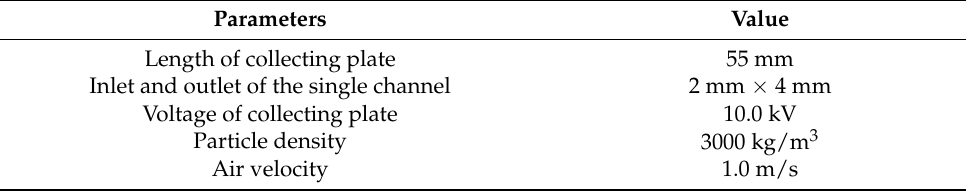
Table 2. Parameters in plate-type micro-electrostatic filter simulation.